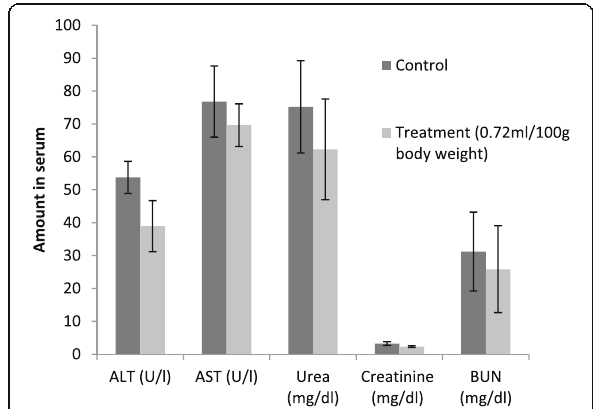
Fig. 6 Effect of the oral administration of the MLCC on hepato (AST,ALT) and renal parameters (urea, BUN and creatinine) of rats. Results are expressed as Mean ± SEM for the number of animals used ( n = 6/group). * p < 0.05 were considered significant when compared with the control (Mann Whitney U